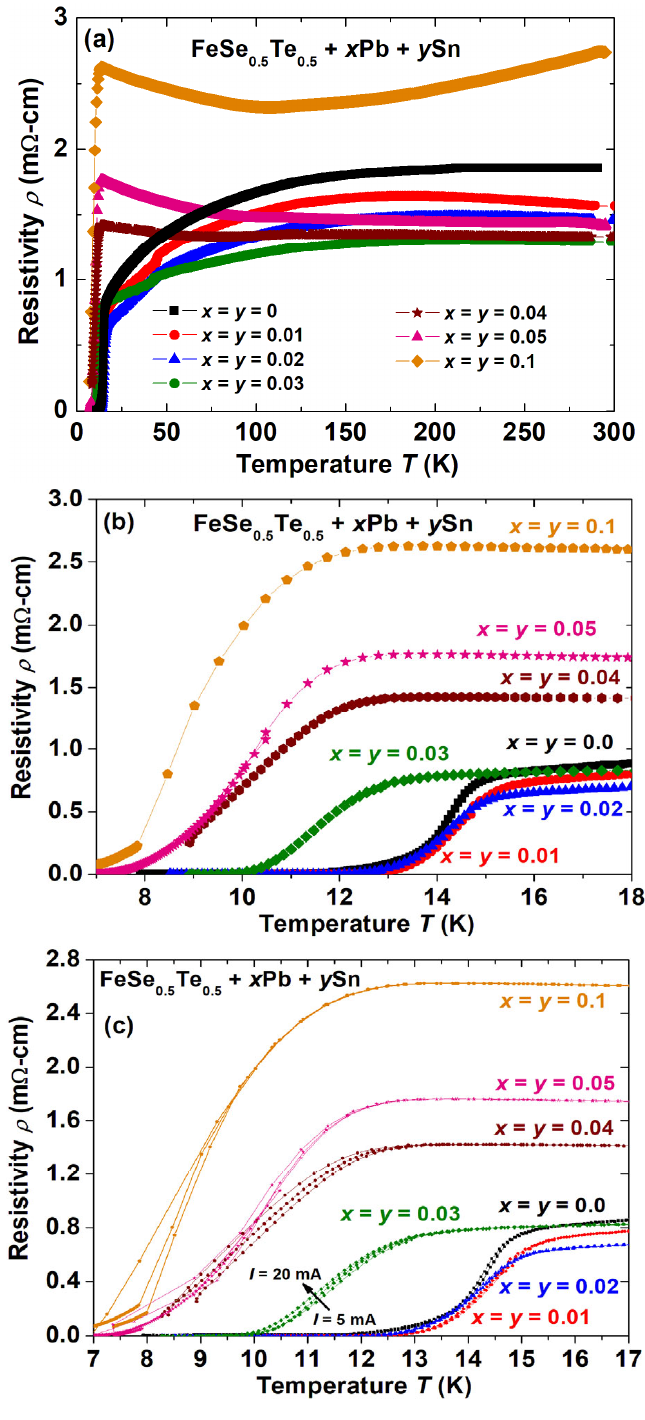
Figure 4. ( a ) The variation of resistivity ( ρ ) with respect to the temperature for all Pb- and Sn-added FeSe 0.5 Te 0.5 bulks (FeSe 0.5 Te 0.5 + x Pb + y Sn ( x = y = 0, 0.01, 0.02, 0.03, 0.04, 0.05, and 0.1)). ( b ) The resistivity behaviours with temperature for various samples in the low-temperature region (<20 K). ( c ) The low-temperature resistivity variation with temperature for FeSe 0.5 Te 0.5 + x Pb + y Sn ( x = y = 0, 0.01, 0.02, 0.03, 0.04, 0.05, and 0.1) with respect to different currents I = 5, 10, 20